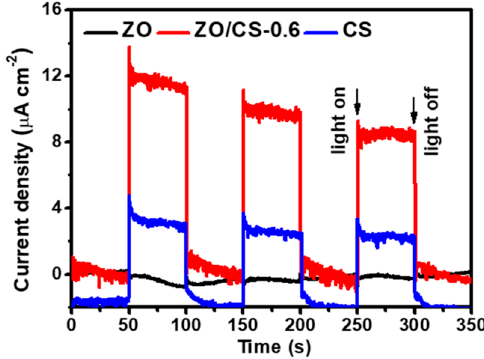
Figure 8. Photocurrent density–time curves of CS, ZO/CS − 0.6, and ZO.